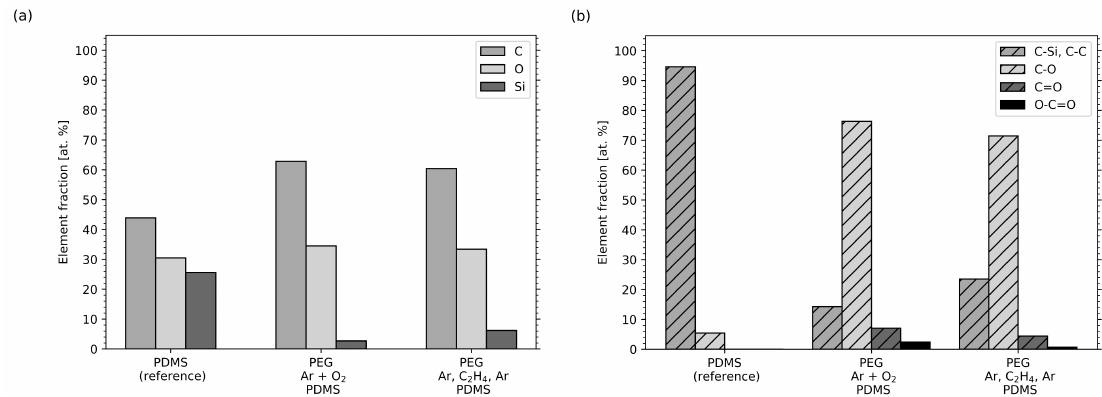
Figure 7. Elemental composition of PDMS and plasma-processed PEG obtained from XPS region scans. The values have been normalized to 100%. ( a ) Single elements and ( b ) chemical